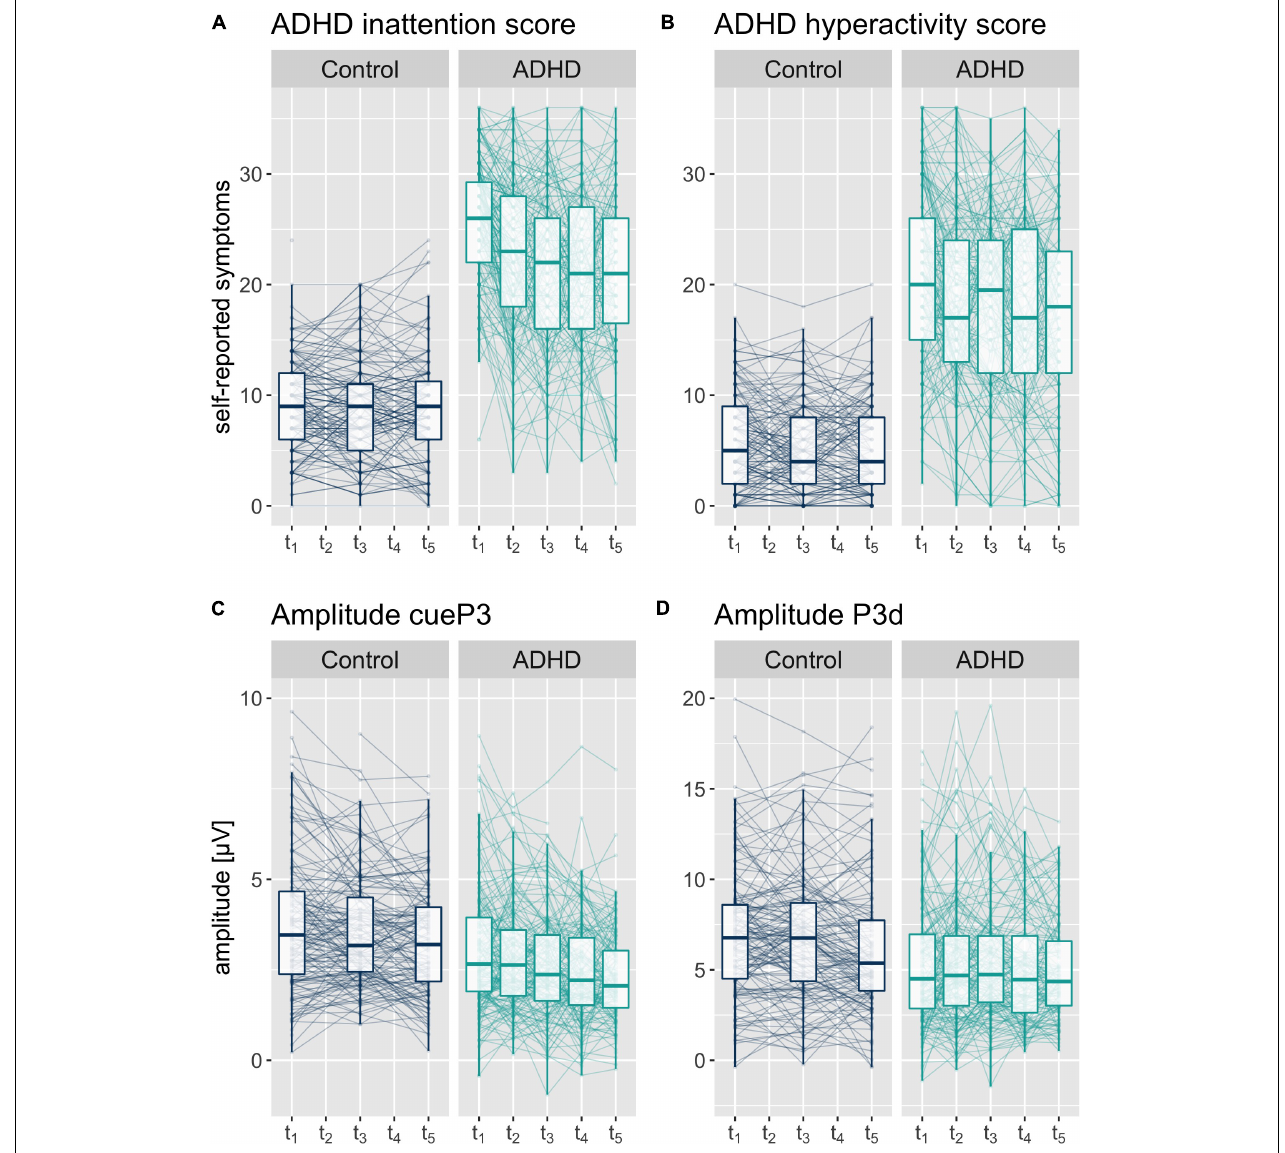
FIGURE 2 | Boxplot with median and 25%-und 75% quantiles and individual values of self-reported symptoms (A) ADHD inattention and (B) ADHD hyperactivity sum score, and (C) cueP3 and (D) P3d amplitudes at the five assessment time points t 1 to t 5 (assessment interval approximately 6